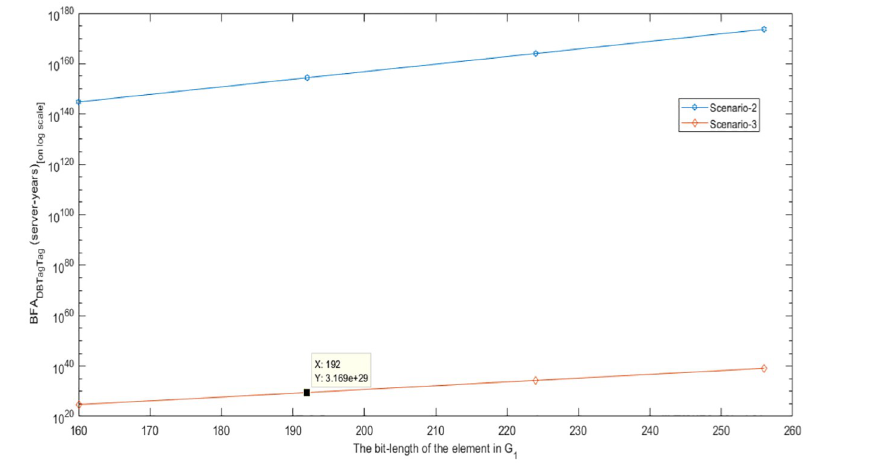
Fig 6. BFA DBTagTag cost: Scenarios-2 vs Scenarios-3 ( L MappingSecretKey = 160 bits).